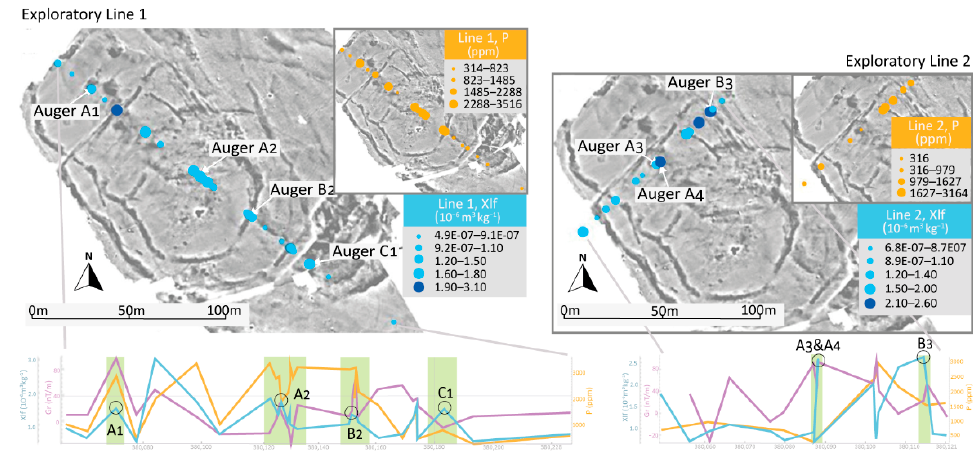
Figure 9. Bubble plots (overlying the magnetometer survey results) showing the lateral low-frequency magnetic susceptibility ( χ lf, in blue) and phosphate (P, in orange) distribution along the exploratory lines at Perdika II. The grayscale image shows positive magnetic anomalies in black and negative anomalies in white. The grayscale image is shown at 70% opacity in Figures 1 and 2 to facilitate visualization of the bubble plots. The x–y graphs also show the lateral variation of the χ lf (blue line) and P (orange line), including the magnetic-gradient intensity (Gr, purple line). In the graphs, the location of the targeted features is indicated in green (the labels A, B and C indicate the different areas). The location of the in-depth augered points is indicated as reference for Figure 10, where the in-depth results are shown. The location of the lines is shown in Figure 2.